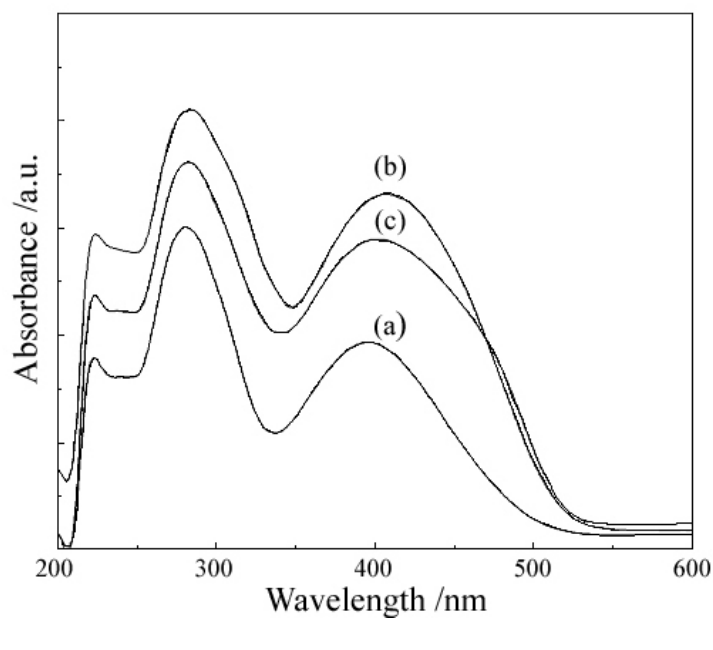
Figure 3. Diffuse reflectance electronic spectra of ( a ) 5-hydroxyflavone